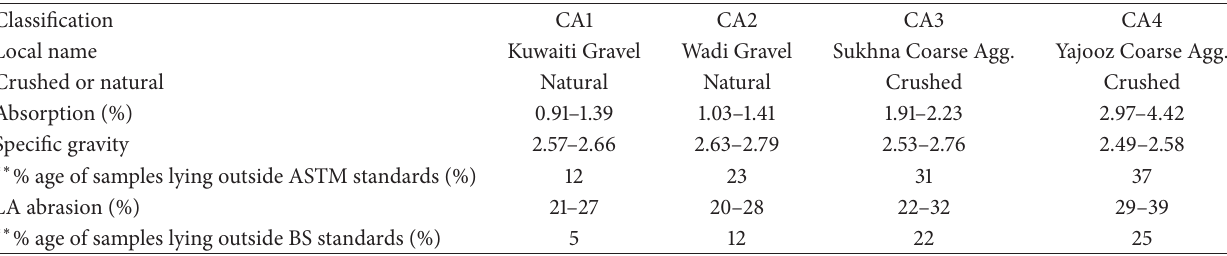
Table 1: Properties of coarse aggregate used in the mix.